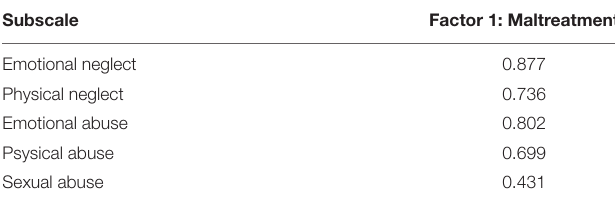
TABLE 2 | Factor loading of Childhood Trauma Questionnaire